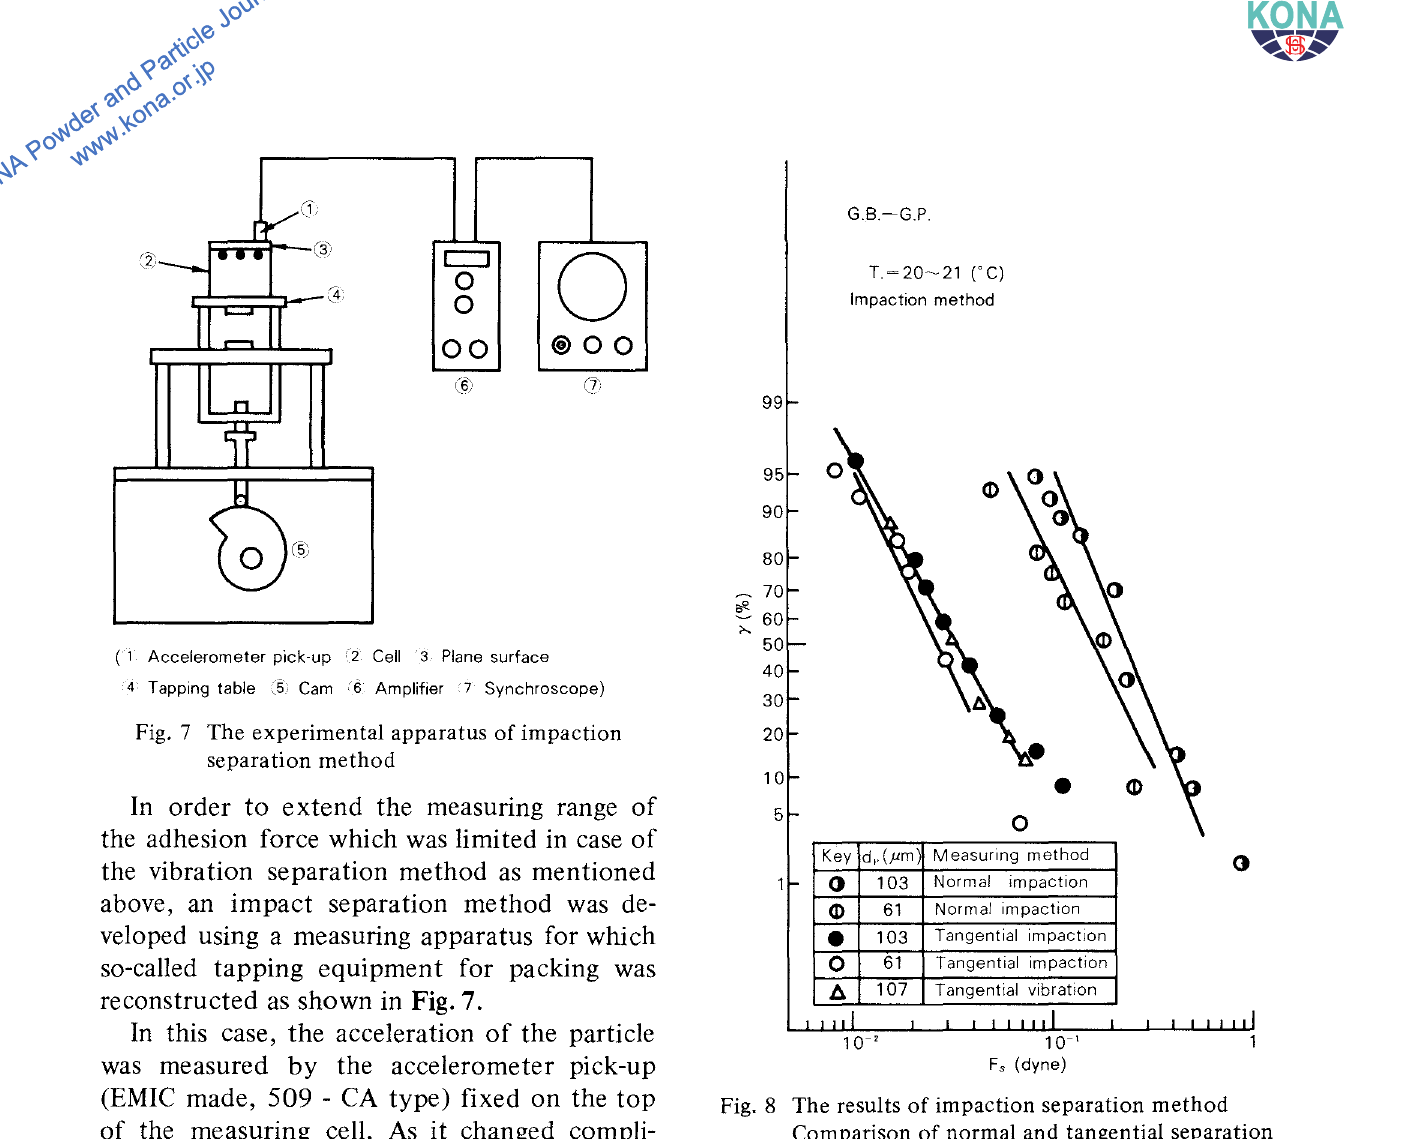
Fig. 8 The results of impaction separation method Comparison of normal and tangential